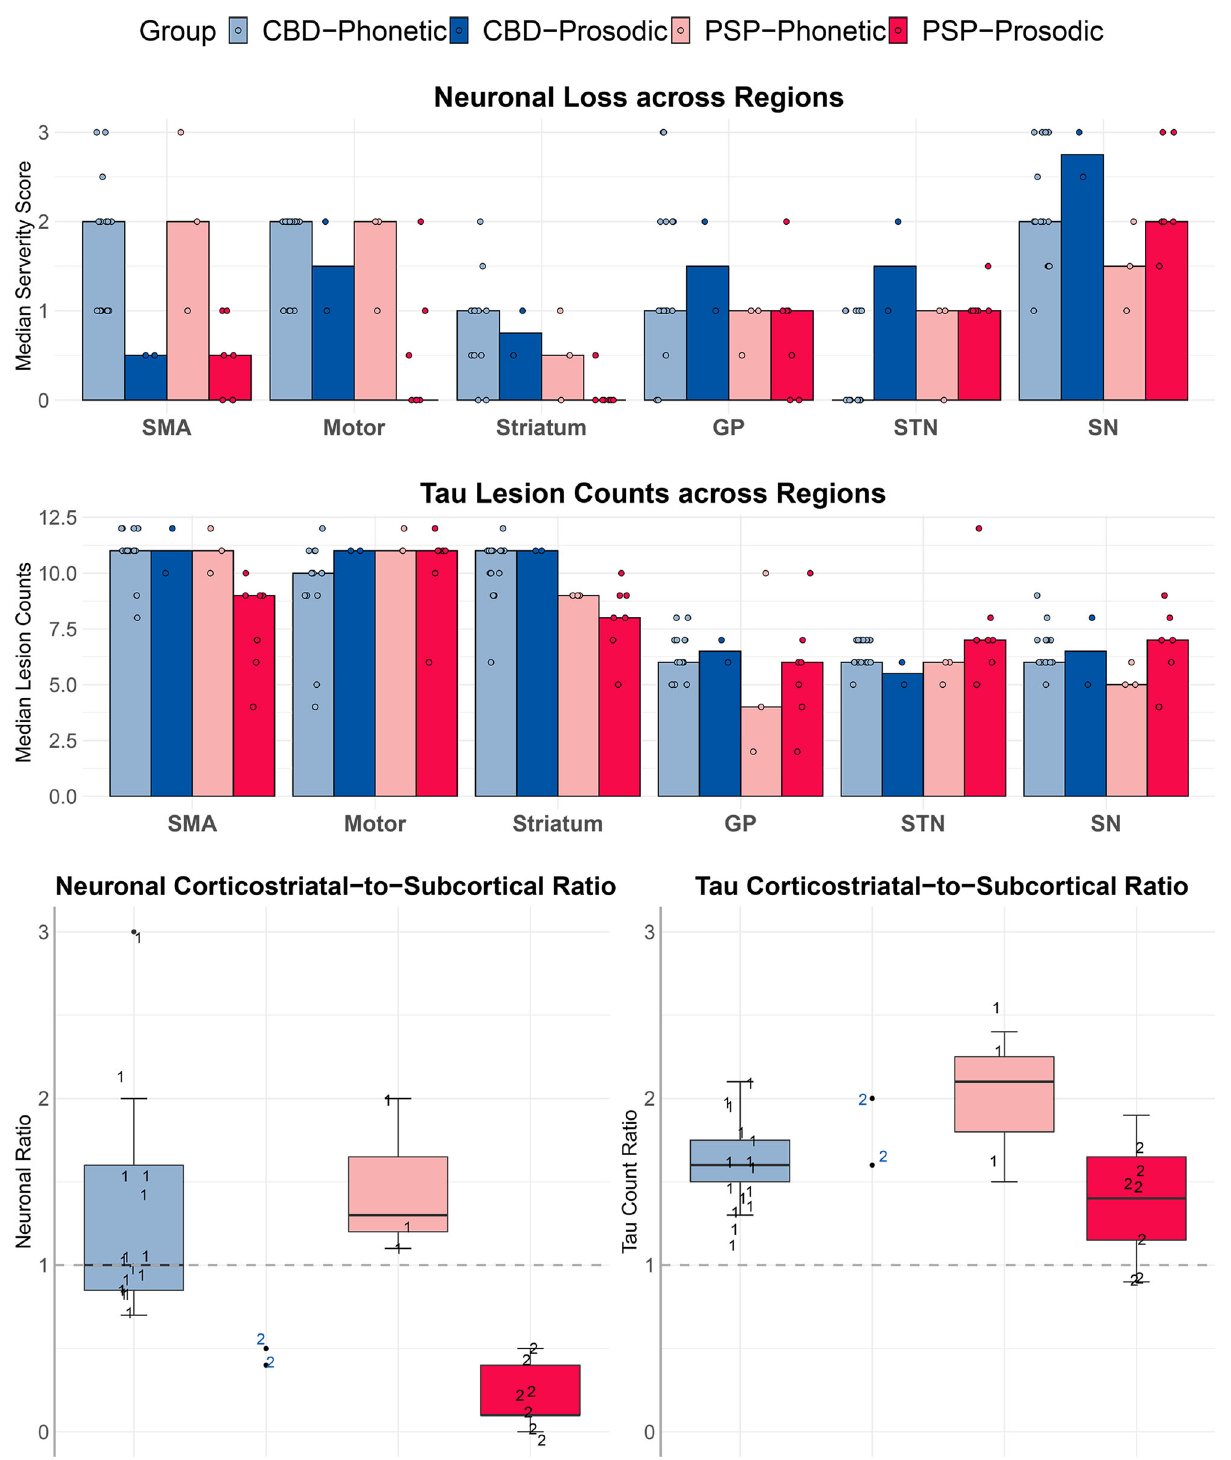
Fig. 6 Histograms of regional neuronal loss and tau counts by pathology and apraxia of speech subtype. The top two histogram plots depict median neuronal loss severity or median total tau lesion count for each region, with all individual points shown. The bottom boxplots depict the ratio between corticostriatal regions (supplementary motor area (SMA), motor, striatum) and subcortical structures (globus pallidus (GP), subthalamic nucleus (STN), and substantia nigra (SN)) for both neuronal loss severity and tau lesion count. The phonetic patients are shown with the number 1 and the prosodic patients are shown with a number 2. Boxes represent lower quartile, median and upper quartile, with whiskers extending to the farthest point at most 1.5*inter-quartile range from each quartile. CBD corticobasal degeneration; PSP progressive supranuclear palsy. N = 15 CBD-phonetic cases; N = 2 CBD- prosodic cases; N = 3 PSP-phonetic cases; N = 7 PSP-prosodic cases. Source data are provided as a Source Data fi le.